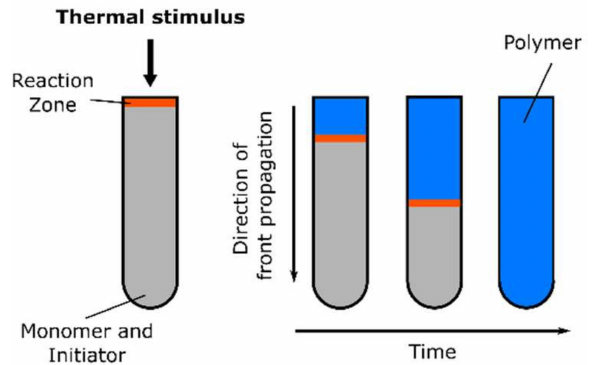
Figure 32. Schematic representation of thermal frontal polymerizations (TFPs) requiring an external stimulus to start an exothermic reaction wave.